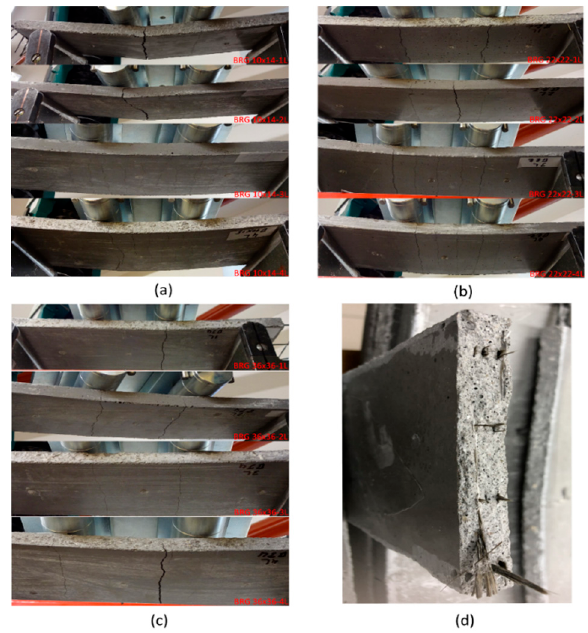
Figure 12. Photographs of cracks distribution of the tested specimens: ( a ) basalt textile of a net size of 10 × 14 mm 2 ; ( b ) basalt textile of a net size of 22 × 22 mm 2 ; ( c ) basalt textile of a net size of 36 × 36 mm 2 ; ( d ) rupture failure of the tested specimen.